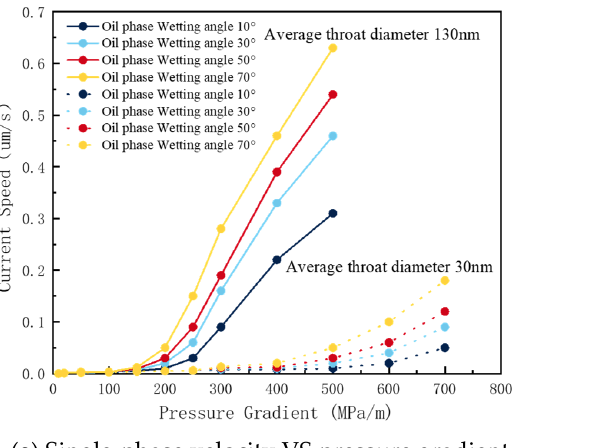
Figure 17. Fluid pressure diagram under different wetting angles of oil. As can be seen from Figure 18, with the increase of wetting angle, the area where oil can flow increases, and the pressure in large-size pores decreases.